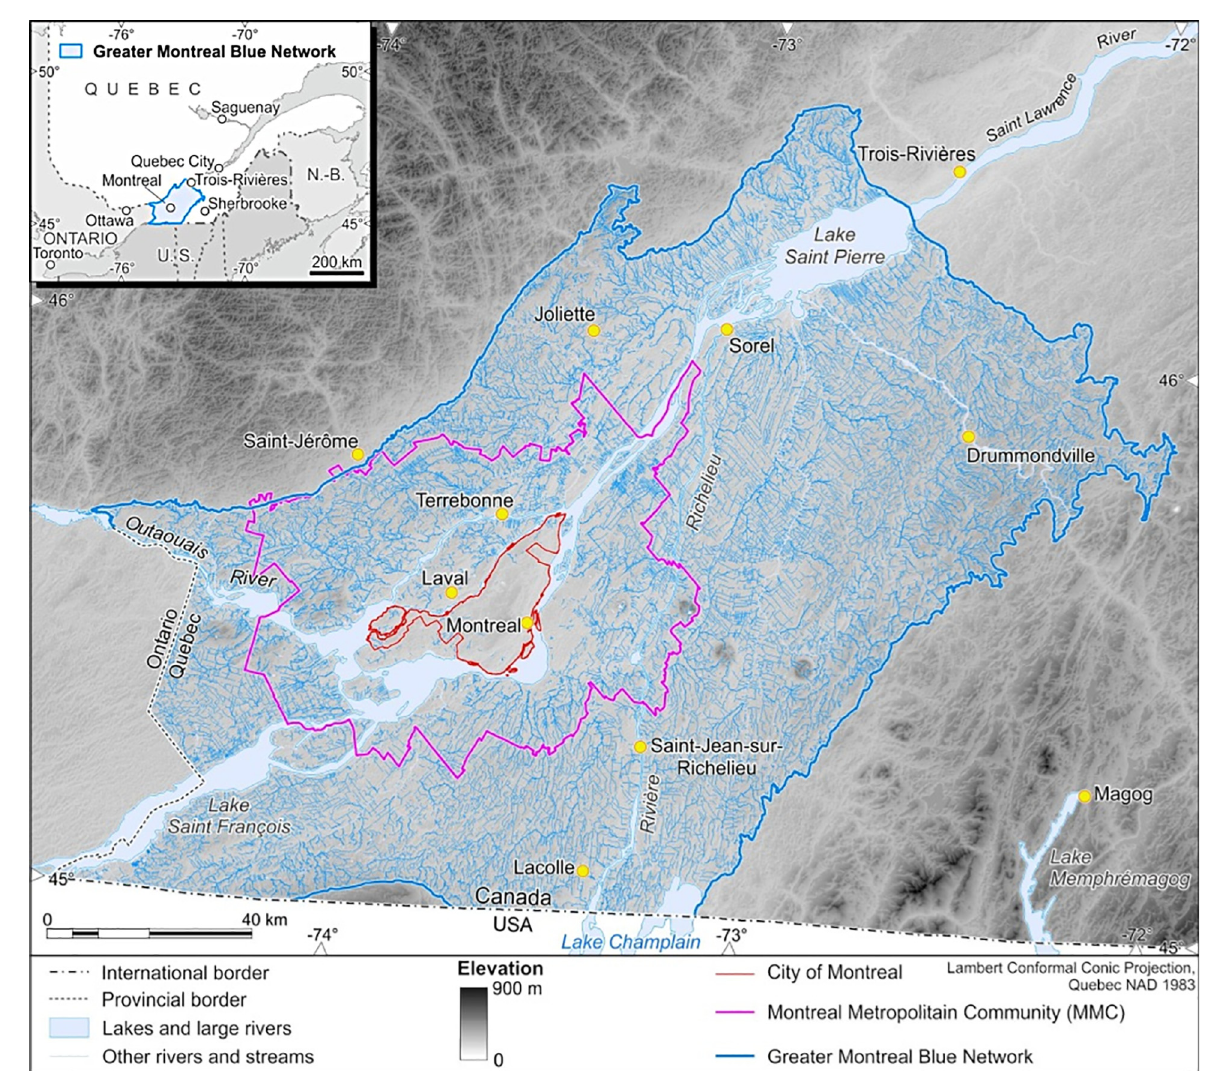
Fig 2. The bodies of water that constitute the Greater Montreal Blue